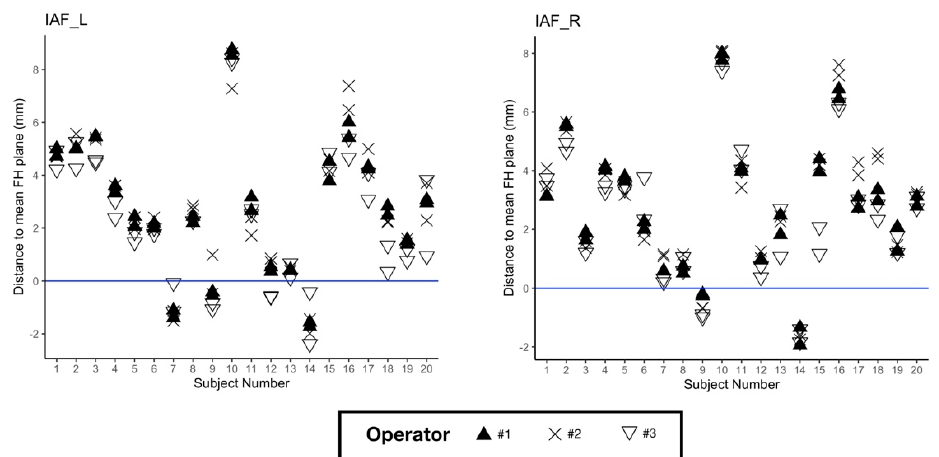
Figure 3. The absolute angular difference between the conventional and the novel FH planes was 2.41° (SD 1.27°).